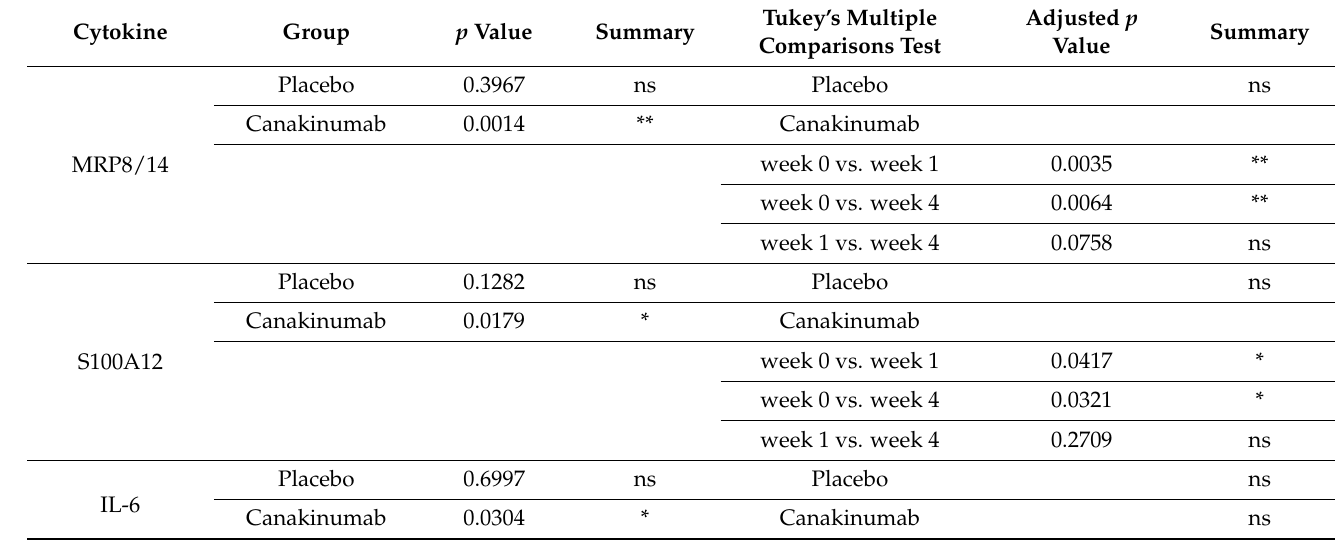
Table 3. Detailed results of one-way repeated-measures ANOVA with Tukey’s multiple comparisons test for placebo